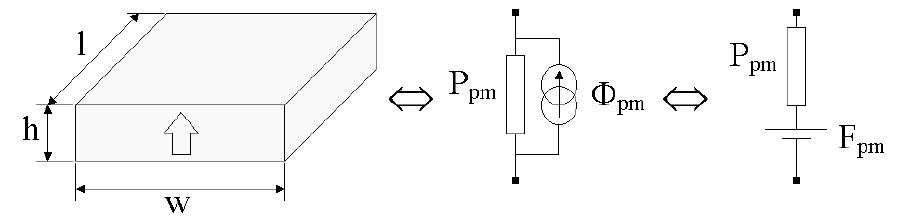
Figure 21. Permanent magnet region modeling.